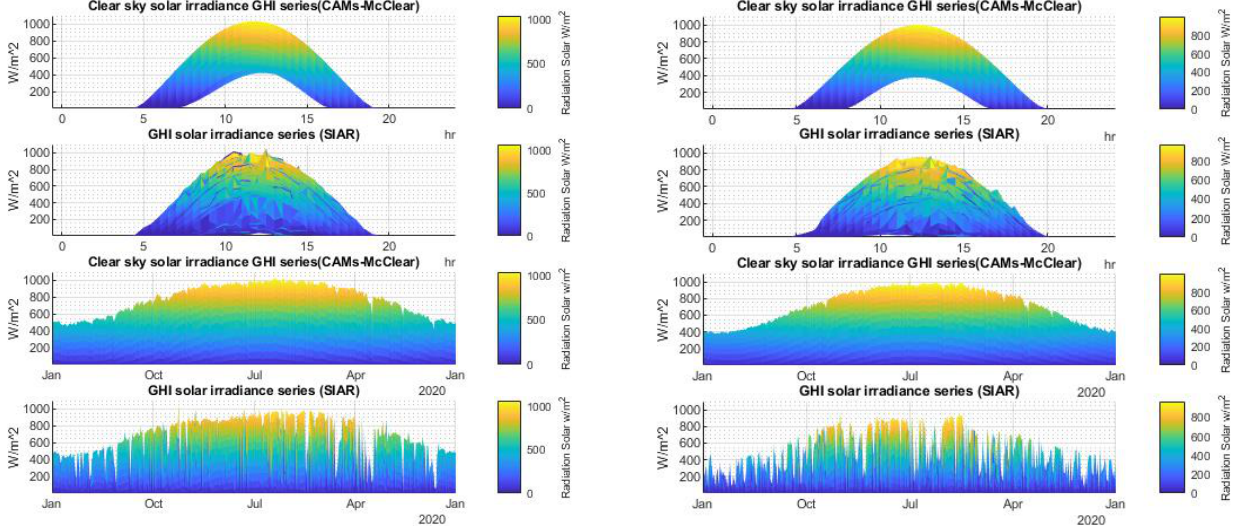
Figure 3. Presentation of GHI and GHIcs for 2 meteorological stations (V29 and C01) in 2020.